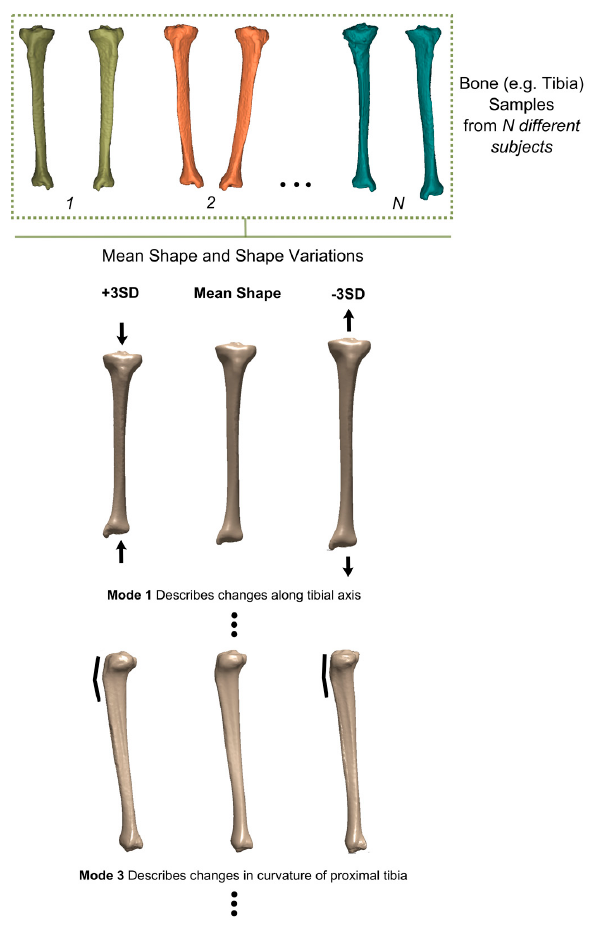
Figure 2. An example of a statistical shape model developed for tibia. Many instances of the bone shape (depicted with different colors) are used to make a mathematical representation of the mean bone shape and the main modes of shape variation from the mean shape. The model has been developed at TU Delft (Researchers: Nazli Tümer and Vahid Arbabi).